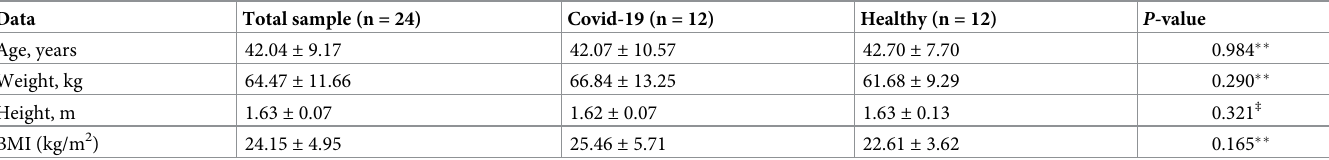
Table 1. Participant demographic data. Mean ± standard